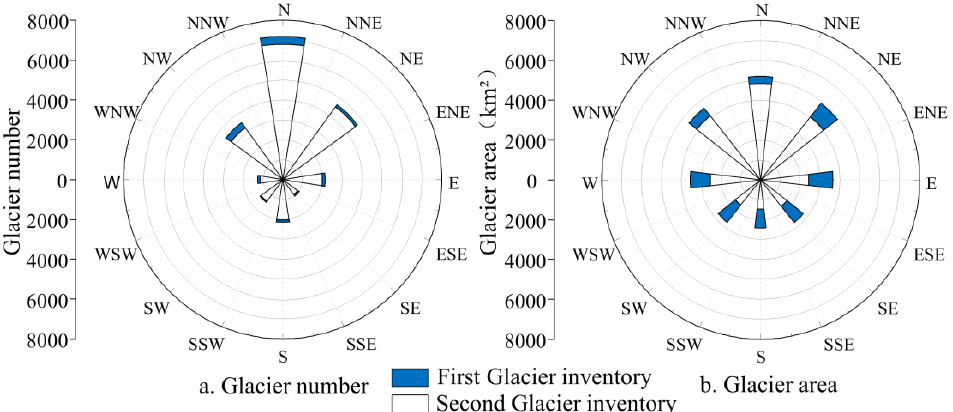
Figure 5. Based on the first and second Chinese Glacier Inventory of different orientations ( a ) and glacier area ( b ) in Xinjiang. glacier area ( b ) in